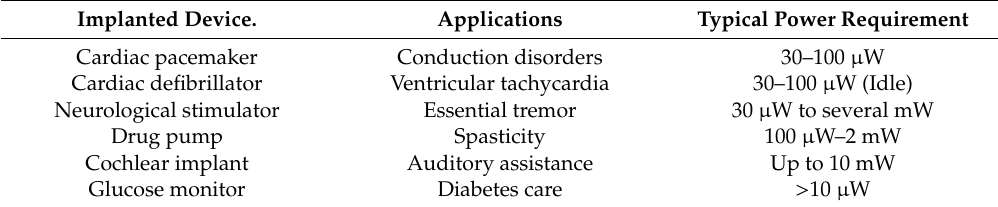
Table 1. Power requirements of common implantable devices.